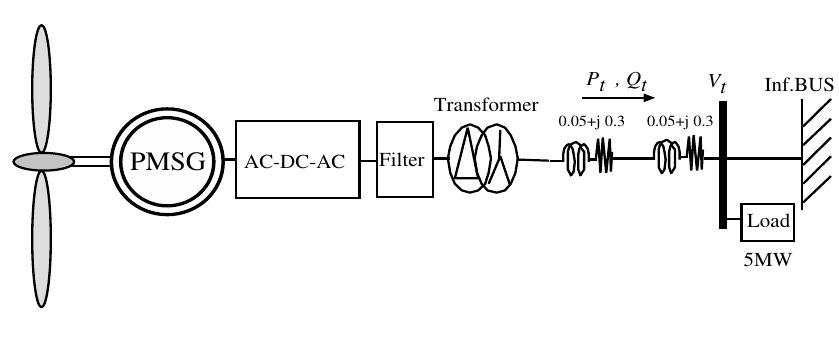
Figure 13. Power system